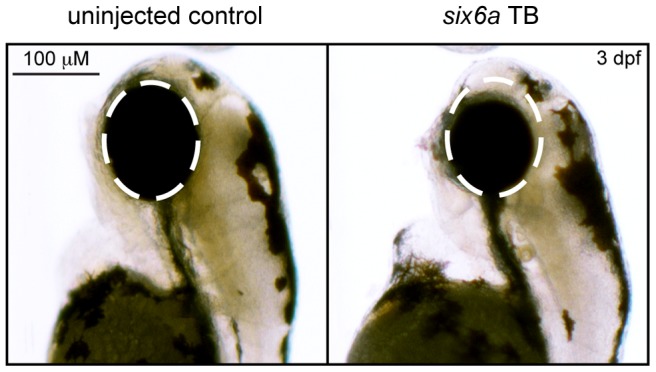
Morpholino knockdown of six6a.Zebrafish were microinjected with a six6a translation blocking morpholino. Lateral images, taken 3 days post fertilization (3 dpf), of a wild-type zebrafish (left) and a morpholino injected zebrafish (right) are shown, highlighting the small eye phenotype (dashed circle).